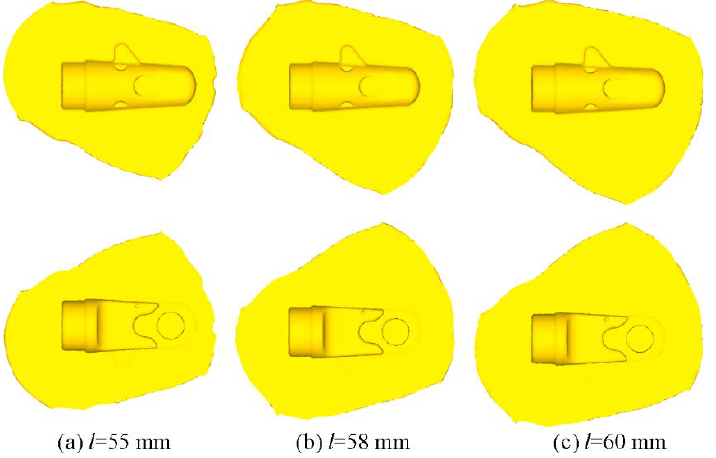
Figure 8. Forming shape of top and bottom part of component under different blanks length: ( a ) l = 55 mm, ( b ) l = 58 mm, and ( c ) l = 60 mm.